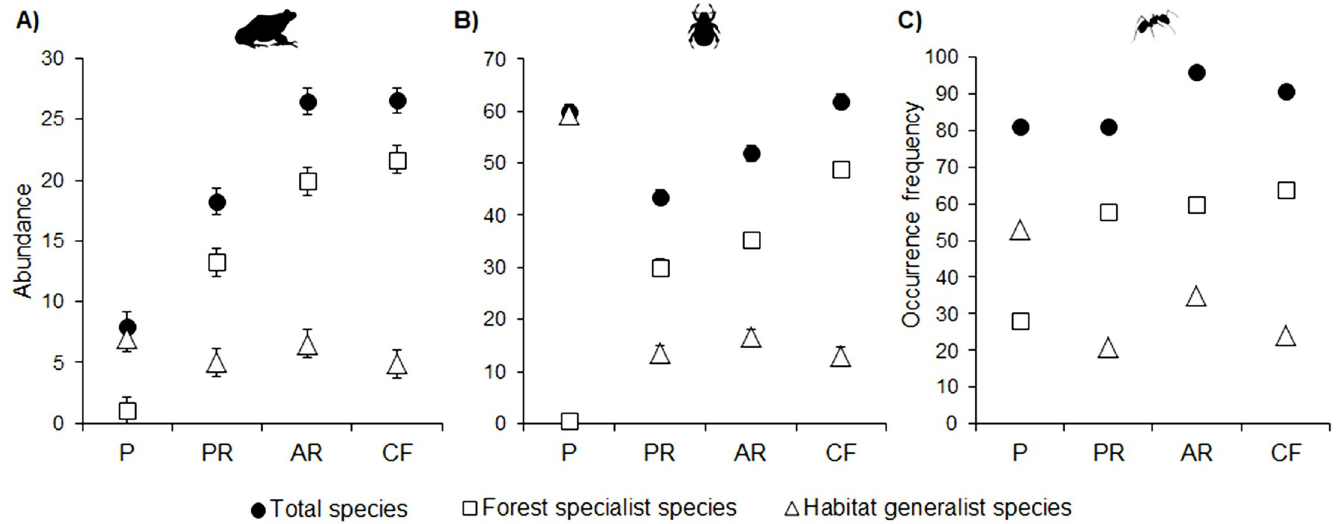
Fig 3. Mean abundance per plot of amphibians (a) and dung beetles (b), and occurrence-frequency of ants (c) in four vegetation types. P = cattle pasture, PR = forest under passive restoration, AR = forest under active restoration and CF = mature cloud forest. Error bars denote standard error. Values of statistical differences among vegetation types are provided in S3 Appendix in (Tables 1 and